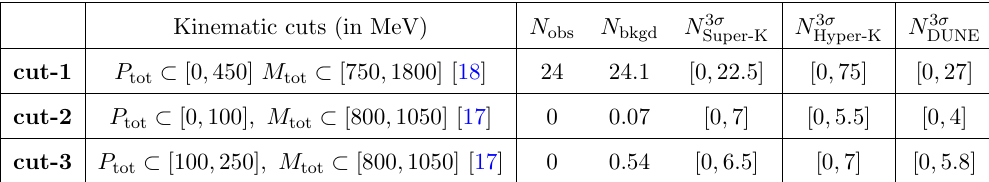
Table 2 . Three kinematic regions from n (cid:0) (cid:22) n oscillations [18] and proton decay [17] searches at Super-K. N 3 (cid:27) is the allowed number of signal events within 3 (cid:27) . The 3 (cid:27) expectation for the Super-K number of signal events at Hyper-K and DUNE is obtained under the assumption that the observed number of events is compatible with the number of background events.